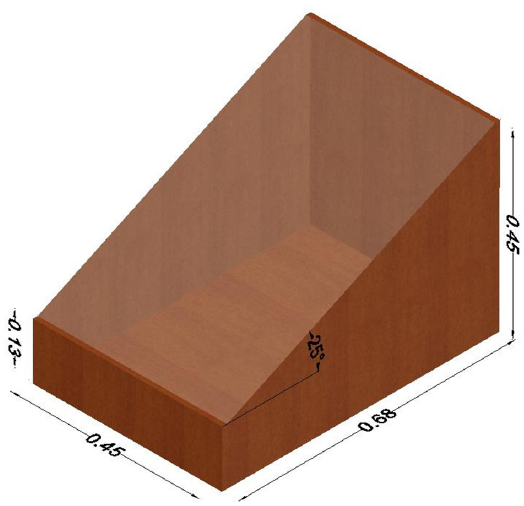
Figure 1. Dimensions in meters of the solar still structure.